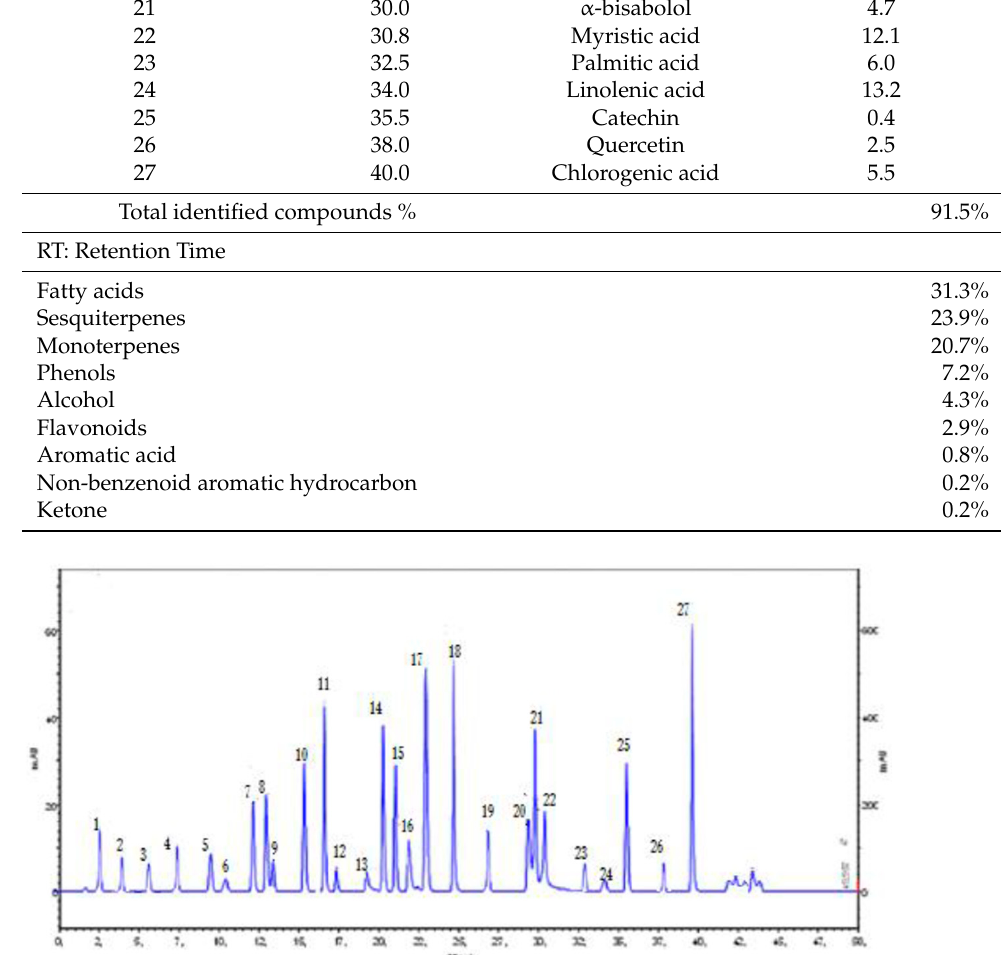
Table 1. Chemical composition of C. incana ethanolic extract.